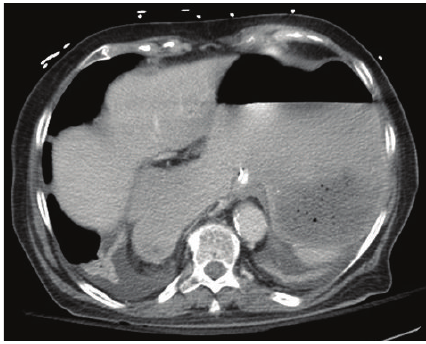
Figure 2: Transverse CT showing severe stomach distension.